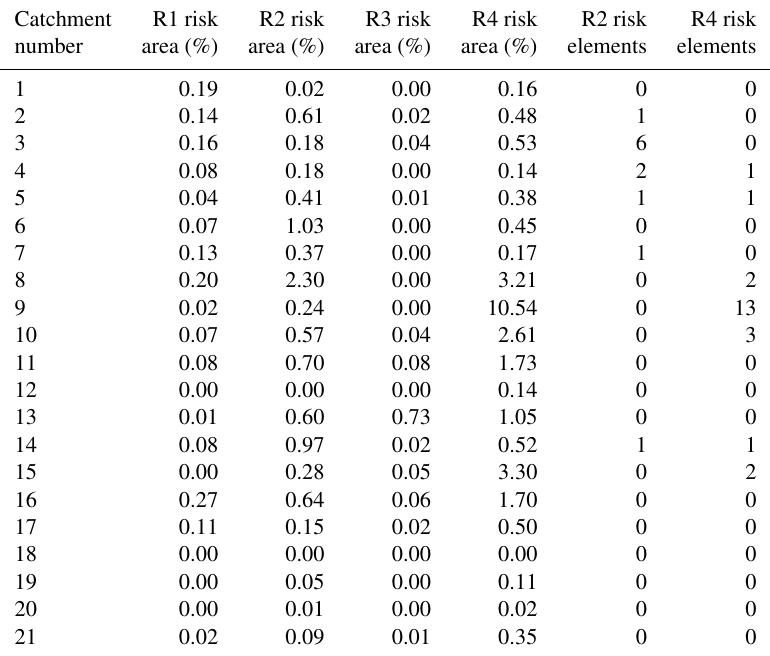
Table 5. The geodatabase with the evaluation of the surfaces (%) and punctual elements of risk in the studied catchments, according to the EU Flood Directive